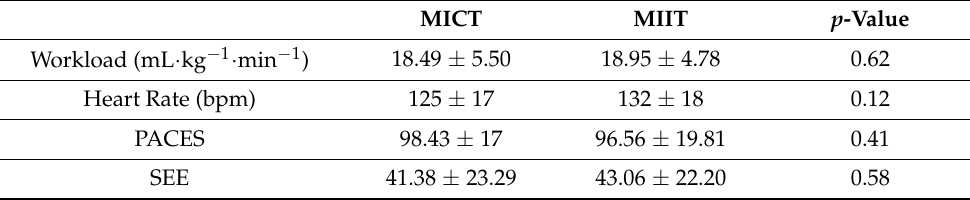
Table 2. Trial Outcome Data.